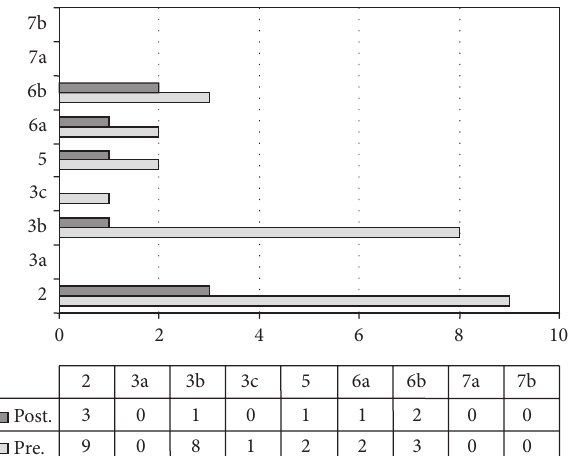
Figure 3: “Di Nuovo” attention test is the number of commission errors on nine attention tasks in baseline (pretreatment) and with MPH treatment (posttreatment). The mean value of all nine ) was compared to the mean value of subscores pretreatment ( 𝑀 pre = 2.78 (SD = 3.42 ) ). 𝑀 all nine subscores posttreatment ( 𝑀 post pre pre = 0.89 (SD = 1.05 ); nonparametric Wilcoxon test versus 𝑀 post post 𝑧 = −2.26 ; 𝑃 < .05 , one-tail. Description of tasks is as follows: